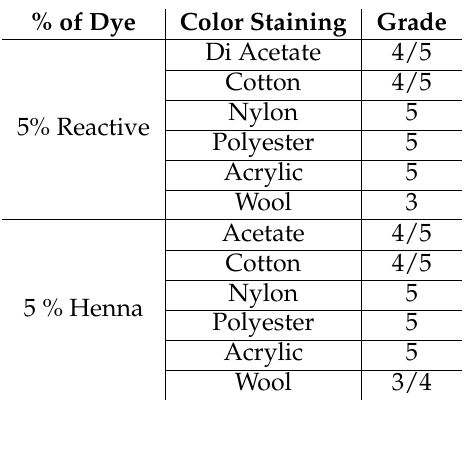
Table 2. Effect of color fastness to washing